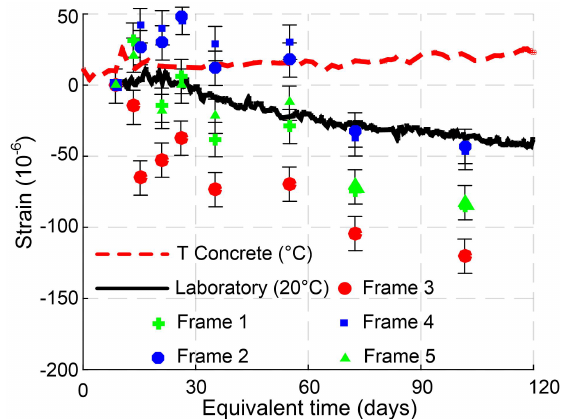
Figure 16. Temperature (dashed red line), strain of structural concrete in the middle level of frames 1 to 5 and strain at the material scale from laboratory measurement (solid black line).